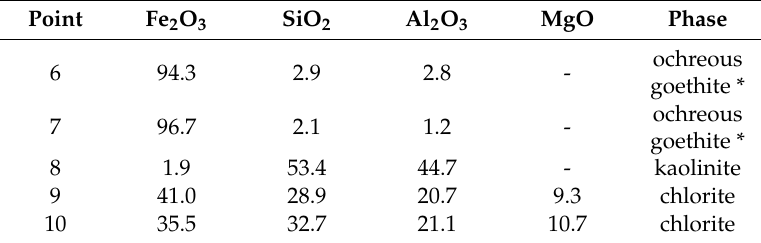
Table 5. EDS analysis from Figure 6, wt